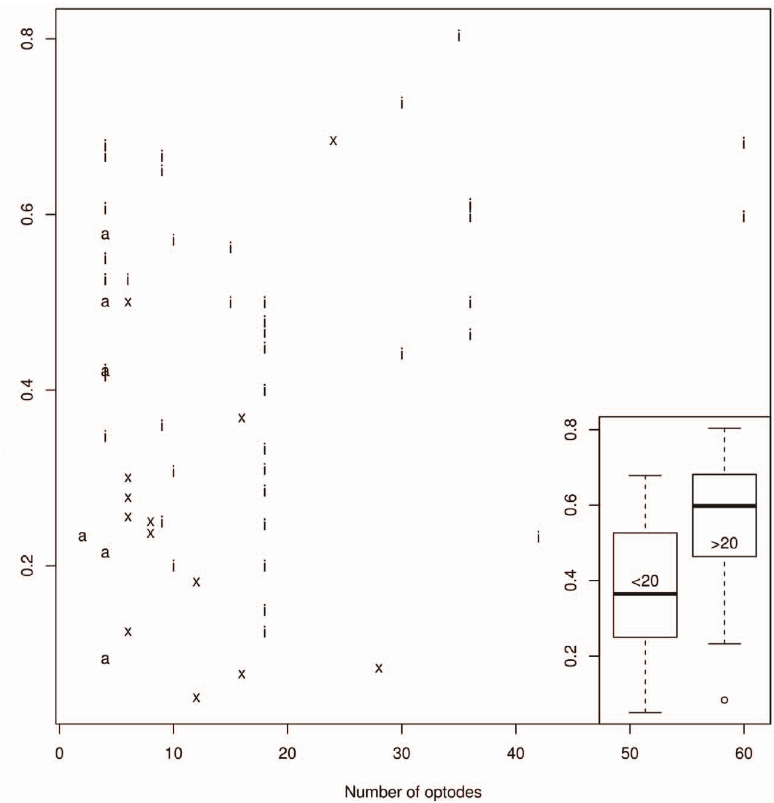
Figure 4. Proportion of infants excluded as a function of number of optodes. Number of optodes is totaled over sources and detectors. Each letter indicates an entry, coding for the system: ‘i’ stands for Hitachi, ‘a’ for Hamamatsu, and ‘x’ for all other systems. The boxplot on the right bottom panel represents the exact same data, collapsing into two categories: less than 20 optodes, and more than 20 optode.